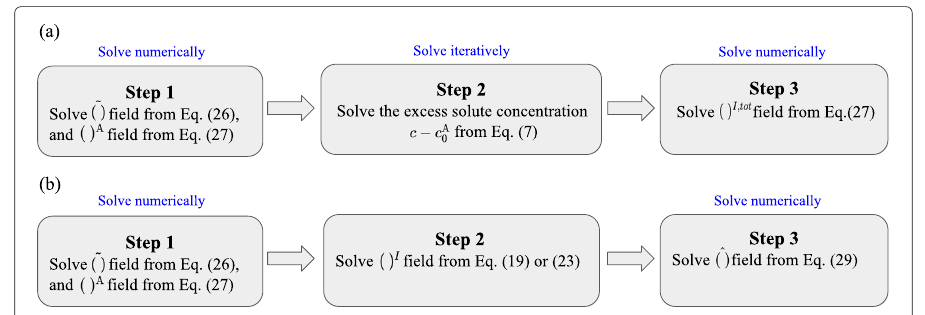
Fig. 3 Flowchart of the numerical scheme to calculate the stress field in a finite volume: ( a ) direct numerical solution; and ( b ) approximate